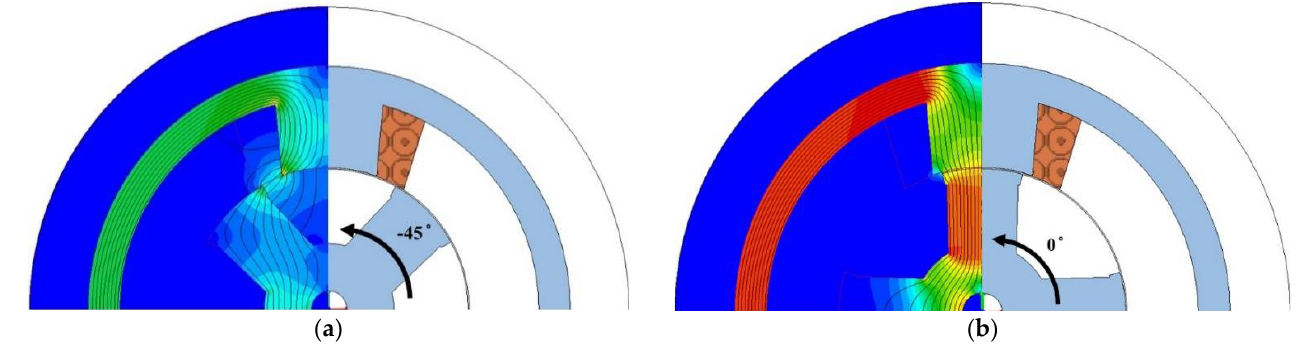
Figure 12. Static simulation positions ( a ) beginning position; ( b ) end position.